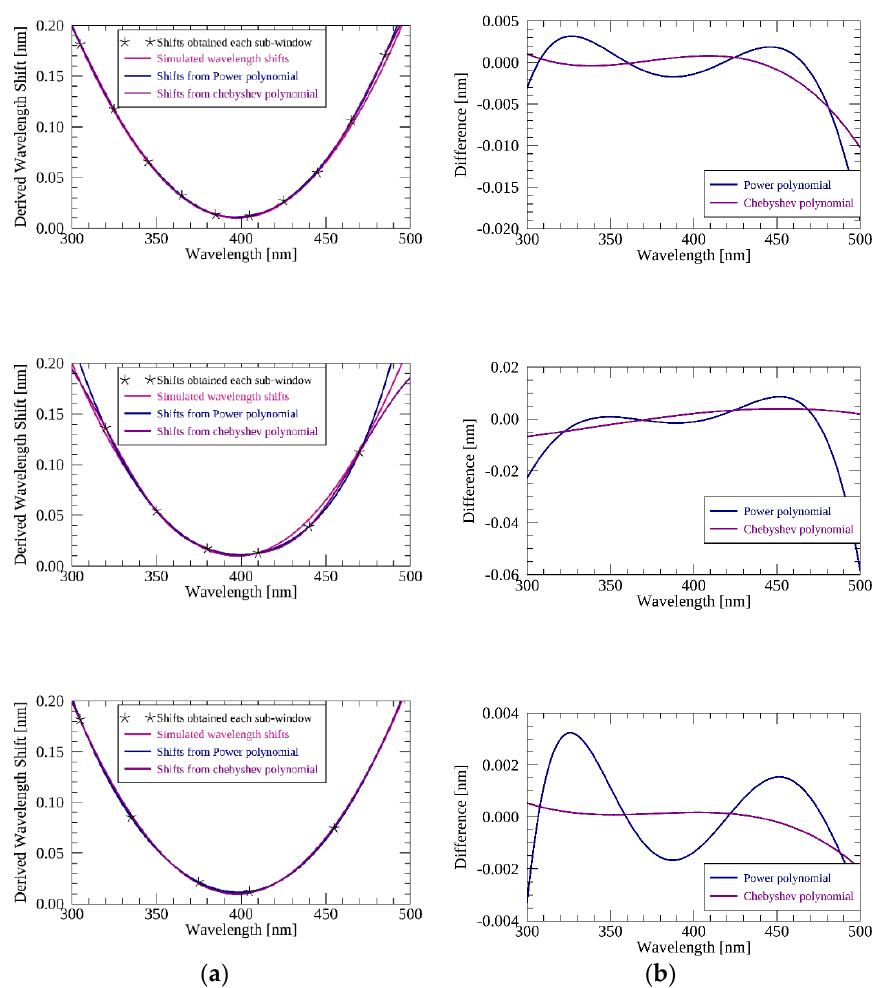
Figure 3. Comparison of wavelength shifts using two polynomials. ( a ) The derived wavelength shifts for each wavelength based on fitted shift parameters (asterisks) using three di ff erent sets of fitting windows and di ff erent polynomial fitting methods. The fitting windows for each plot are as follows. Top: 10 sub-windows with 10 nm width at 10 nm intervals. Middle: six sub-windows of 30 nm width at 30 nm intervals, at 305–335, 335–365, 365–395, 395–425, 425–455, and 455–485 nm. Bottom: six sub-windows of 10 nm width spaced to include the beginning and end of the wavelength range, at 300–310, 330–340, 370–380, 400–410, 450–460, and 490–500 nm. Magenta lines are the simulated wavelength shifts applied in the tests ( C h 0 : 0.01; C h 1 : 0.0001; C h 2 : 0.00002), and asterisks are fitted shifts from each sub-window. Purple and blue lines represent the derived wavelength shifts based on Chebyshev and power polynomials, respectively. ( b ) The di ff erence between the simulated and derived wavelength shifts at each wavelength was obtained using either a power (dotted line) or Chebyshev (dashed line) polynomial. The Chebyshev polynomial gives more consistent shifts with the simulated wavelength